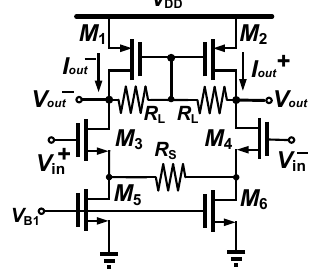
Figure 5. Schematic of A-type gain cell.